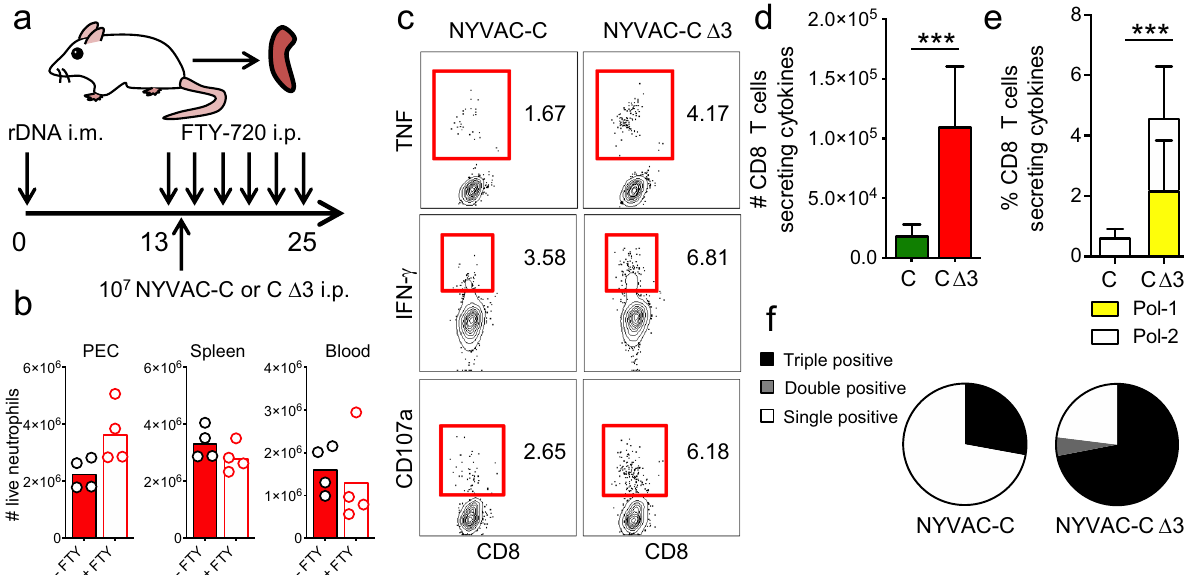
Fig. 2 Splenic HIV-speci fi c T-cell responses is increased after NYVAC-C Δ 3 infection. Vaccine-induced HIV-1-speci fi c CD8 T-cell responses from spleen of mice ( n = 4 per group) primed intramuscularly with recombinant DNA, infected with 10 7 PFUs of NYVAC-C or NYVAC-C Δ 3 and injected with FTY720 every other day starting from the day before infection (a) . Neutrophil total numbers in peritoneal cavity (PEC), spleen, and blood of NYVAC-C Δ 3-injected and FTY720- or PBS-injected mice ( b ). The response was measured 11 days after the last immunization, after splenocyte stimulation with HIV-1 peptides. Contour plots of CD8 T cells that produce IFN- γ , TNF, and CD107a after NYVAC-C or NYVAC-C Δ 3 infection (c) . Total numbers (d) or percentages of Pol-1-, Pol-2-speci fi c (e) CD8 T cells that express IFN- γ and/or TNF and/or CD107a. Nonspeci fi c responses of mice infected with control NYVAC-WT were subtracted from the total value. Graphs show mean ± con fi dence interval (CI). Pie chart colors indicate the relative percentage of cells producing three (black), two (gray), or one (white) activation markers (f) . Data are representative of two independent experiments. *** P <